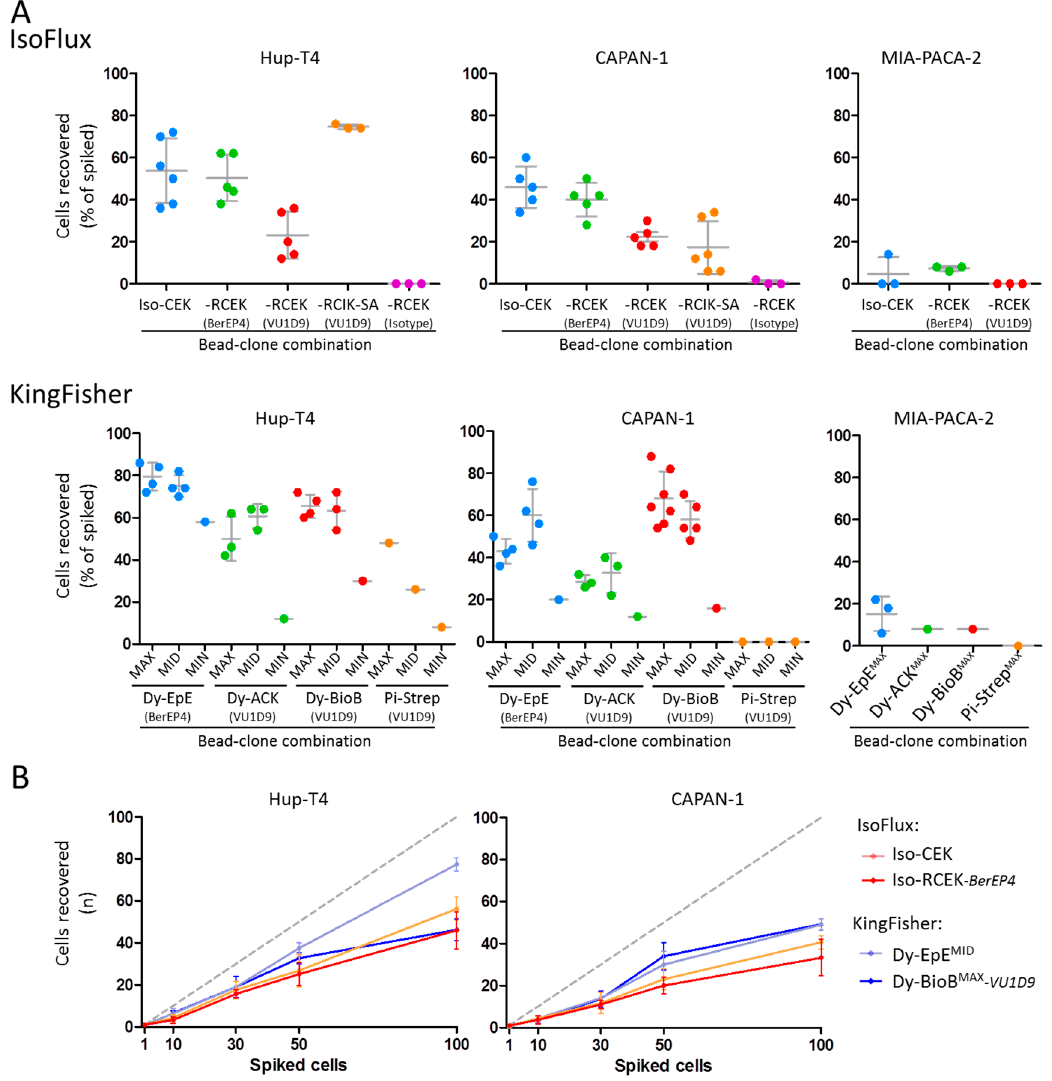
Figure 3. EpCAM-based recovery of HuP-T4, CAPAN-1 and MIA-PACA-2 cells spiked in mimicked-DLA products. ( a ) Recovery of 50 pre-labeled cells from the three lines using the IsoFlux system and three types of beads available from Fluxion (Iso-CEK, Iso-RCEK, and Iso-RCIK-SA) (upper panels) and using the KingFisher Duo system running the WuDuo1 program three different amounts (“MAX”, “MID” and “MIN”) of four types of beads available from Thermo Scientific (Dy-EpE, Dy-ACK, Dy-BioB, and Pi-Strep) (lower panels). ( b ) Recovery of different numbers of spiked pre-labeled HuP-T4 and CAPAN-1 cells using Iso-CEK and Iso-RECK -BerEP4 beads in the IsoFlux system, and Dy-EpE MID and Dy-BioB MAX -VU1D9 beads in the KingFisher Duo system.